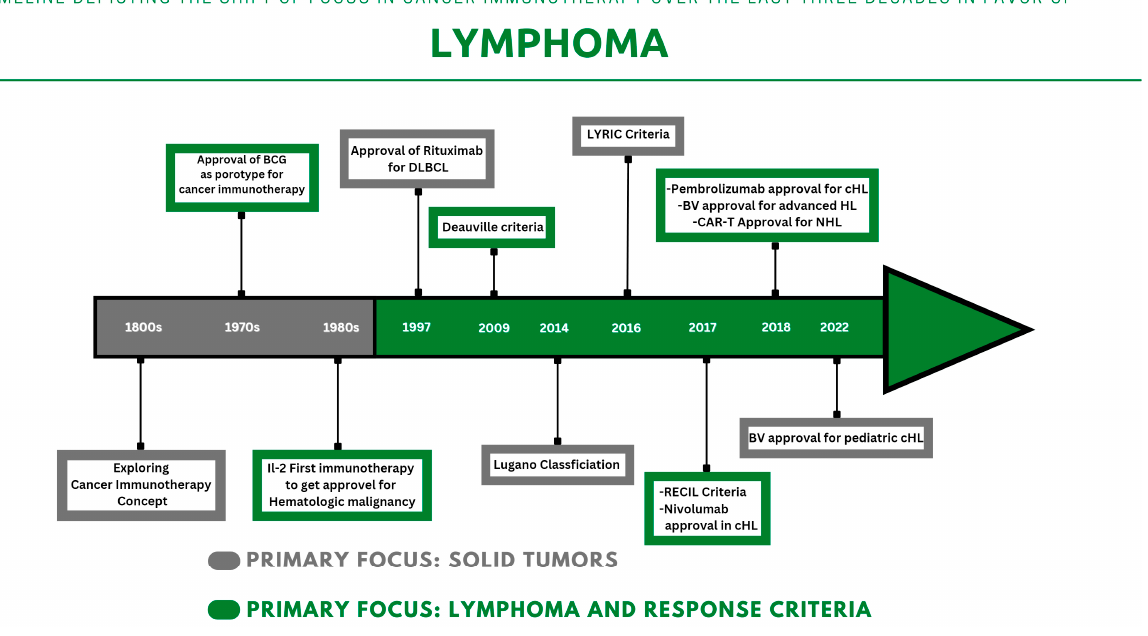
Figure 1. Timeline Depicting the shift of focus in cancer immunotherapy over the last three decades in favor of lymphoma.